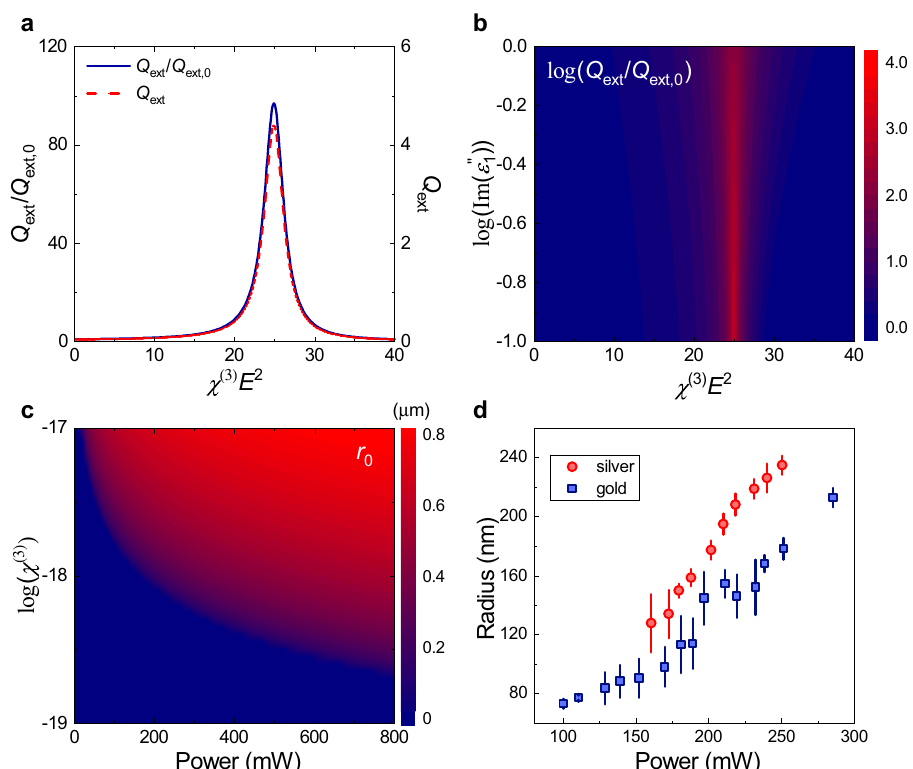
Fig. 4 Analysis of extinction coef fi cient and orbital radius. a Extinction coef fi cient Q ext (i.e., extinction cross-section normalized by the geometry cross- section π a 2 ) and its enhancement Q ext Q , where Q ext ; 0 is the extinction coef fi cient without nonlinearity. b Extinction enhancement with different ext ; 0